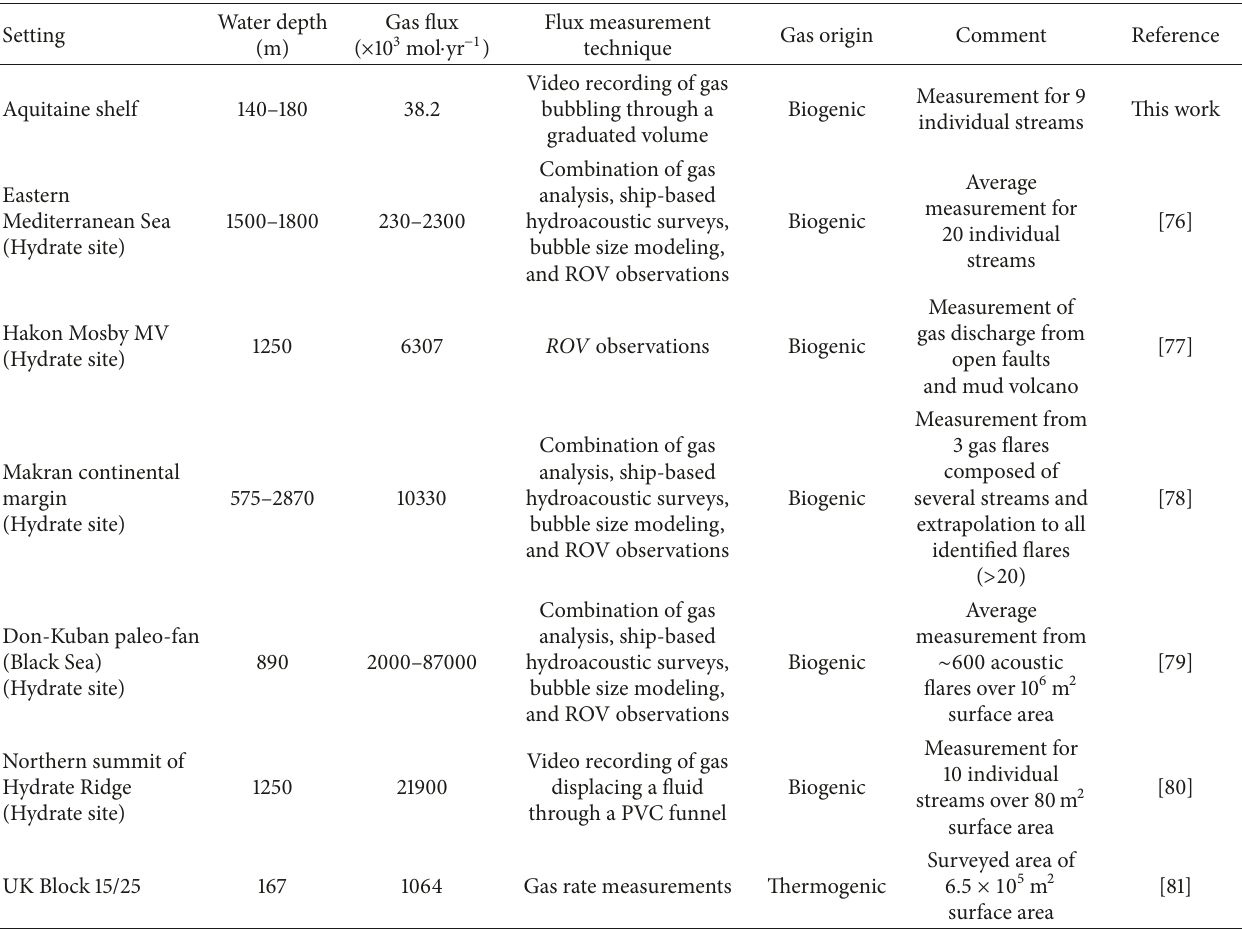
Table 3: Comparison of gas-bubble fluxes from different